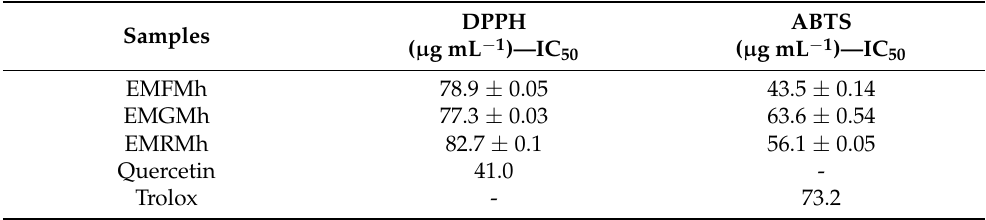
Table 4. Antiradical activity towards DPPH and ABTS of methanol extracts of M. hirsuta (mean ± standard